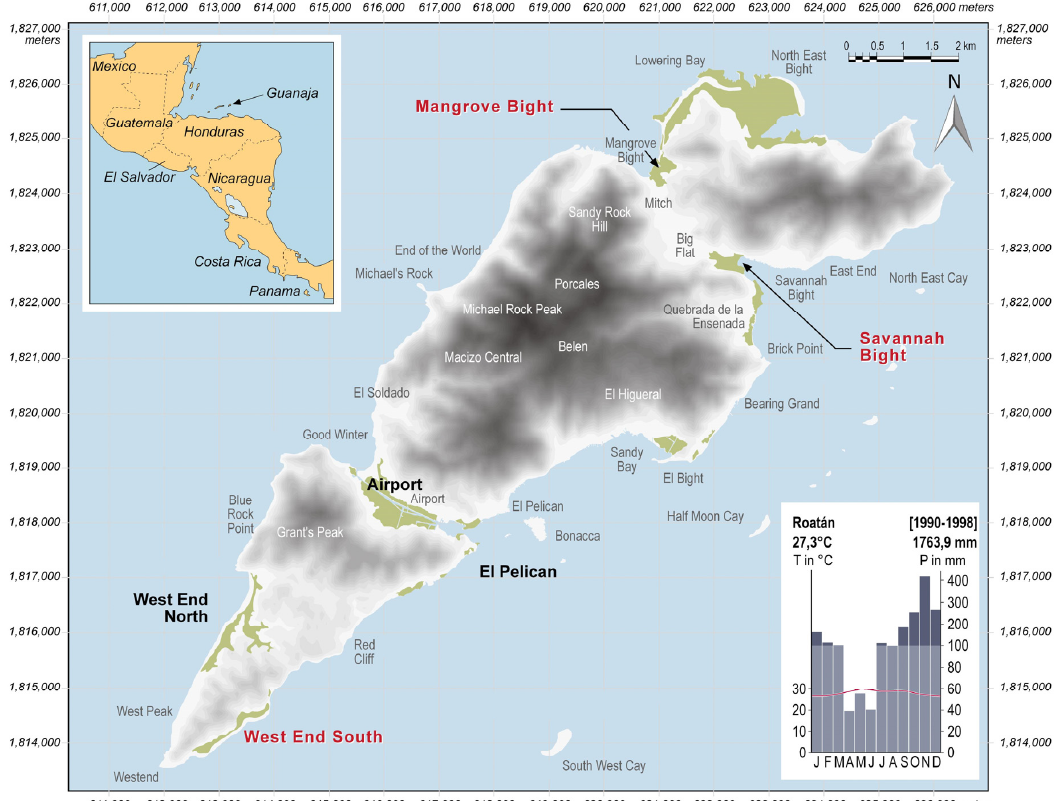
Figure 1. Shaded relief of Guanaja (SRTM data); highlighted in green are mangrove areas; those observed in the long-term monitoring project [37] are labeled in bold letters; the three most severely disturbed ones considered in this paper are labeled in red (Mangrove Bight (MB), Savannah Bight (SB), West End South (WES)); the climate chart of the neighboring island of Roatan displays the overall climatic conditions of the Bay Islands.